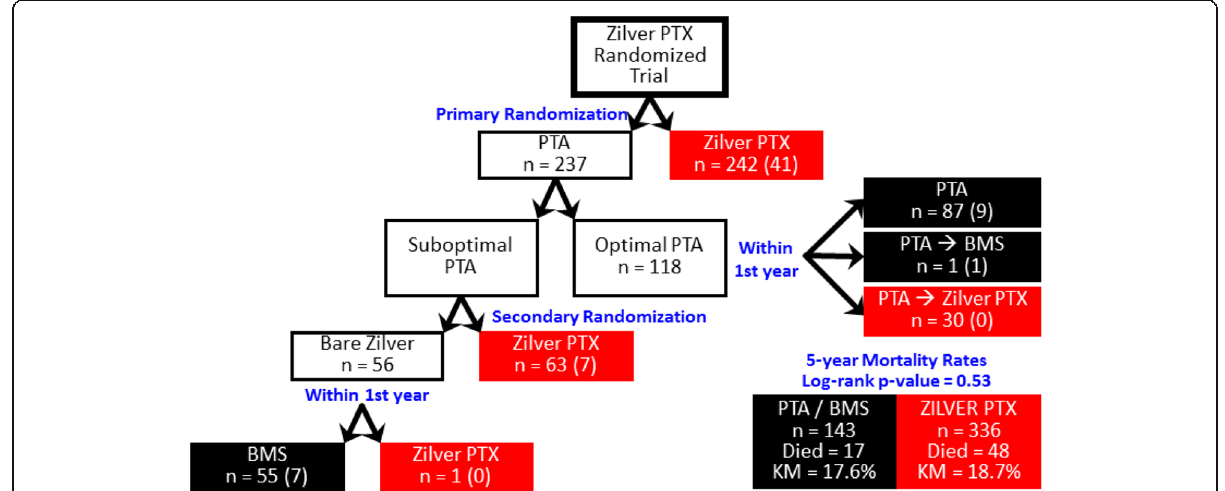
Fig. 1 Flow chart for the Zilver PTX RCT showing long-term failures and 5-year mortality